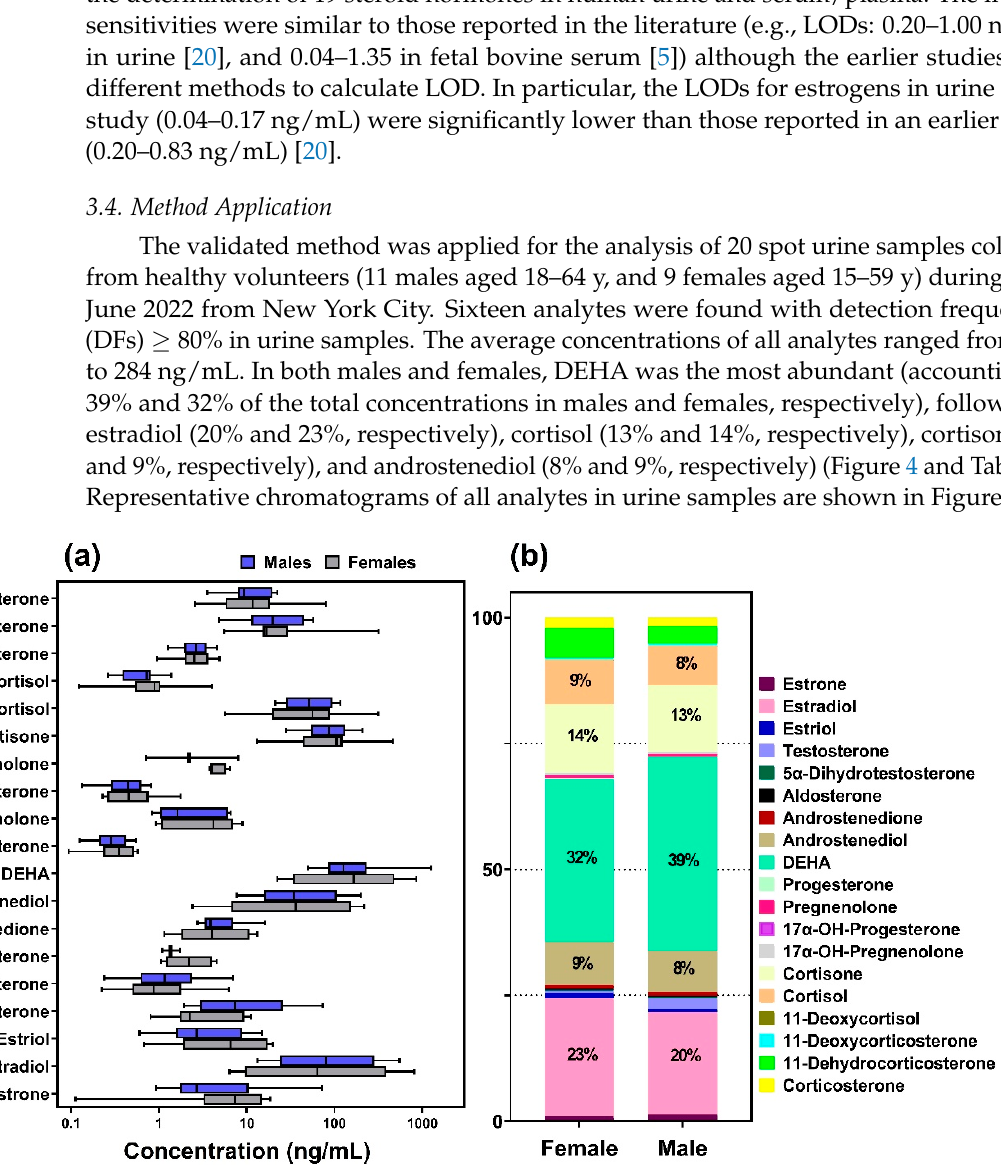
Figure 4. Concentrations ( a ) and relative distribution ( b ) of 19 steroid hormones measured in urine from 11 males and 9 females from New York, United States. Mean concentrations were used in the calculation of the percent contribution.